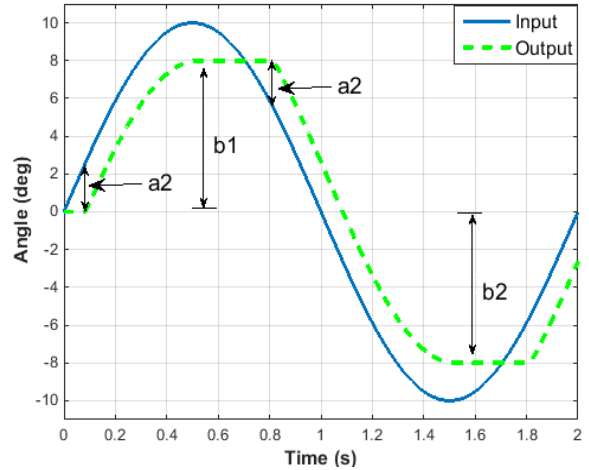
Figure 3. Interaction between the two threshold and the two saturation